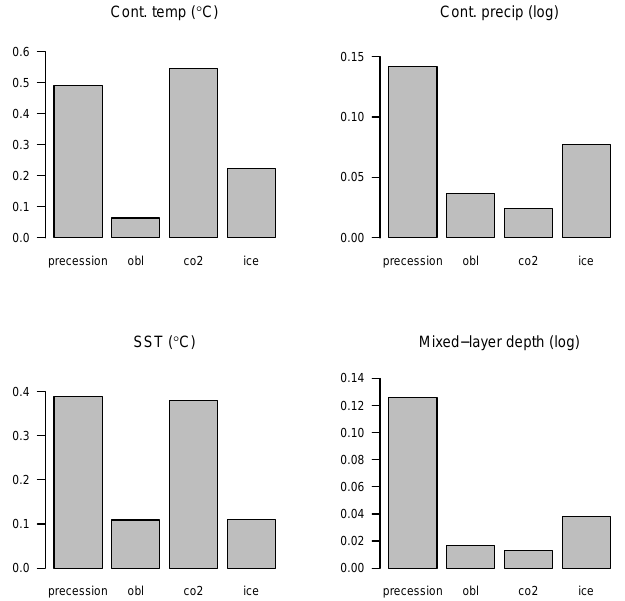
Figure 9. Sensitivity analysis: shown is the standard deviation of p S ) of each variable, induced by variations in in- model outputs ( put factors during the Pleistocene. From left to right, top to bottom: continental precipitation, continental temperature, sea-surface tem- perature and mixed-layer